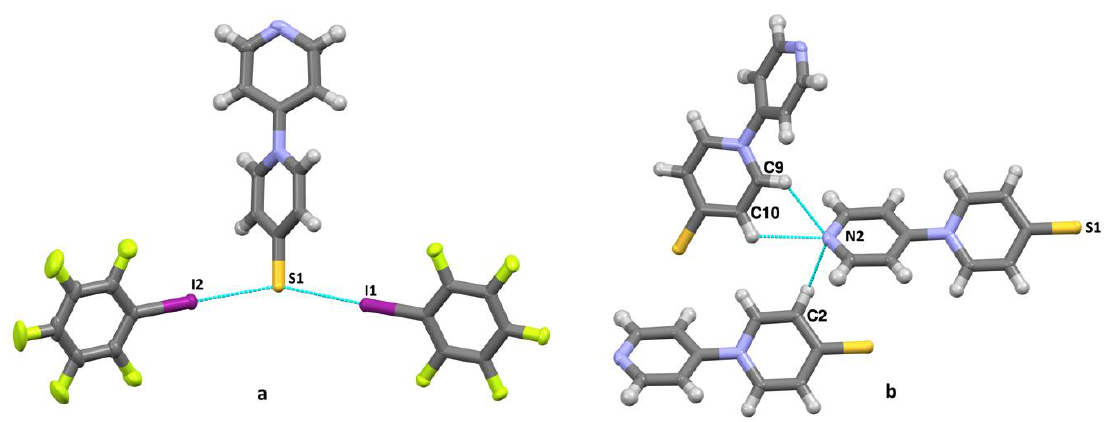
Figure 4. Nonvalent interactions in 3 involving S and N acceptors. ( a ) XBs on S; ( b ) H ··· N contacts.